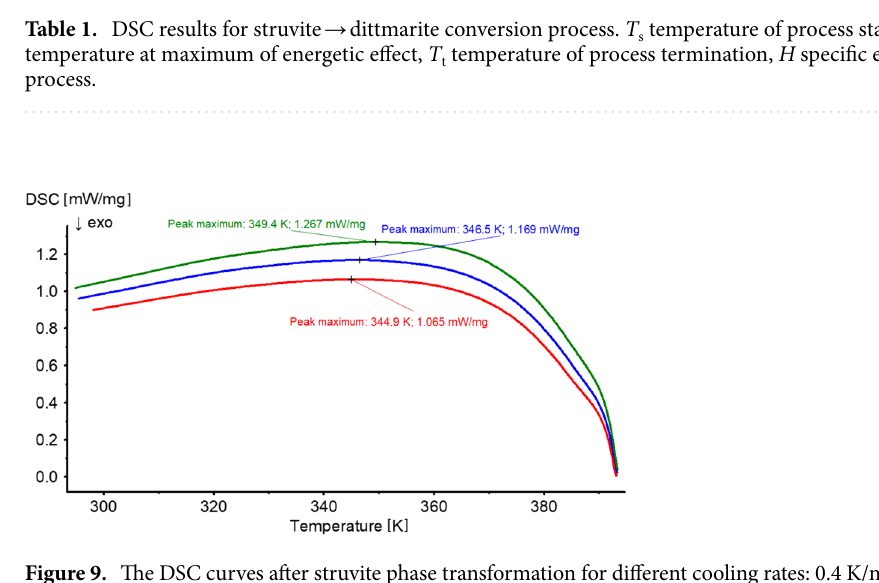
Figure 9. The DSC curves after struvite phase transformation for different cooling rates: 0.4 K/min (red), 1.2 K/ min (blue), 2.0 K/min